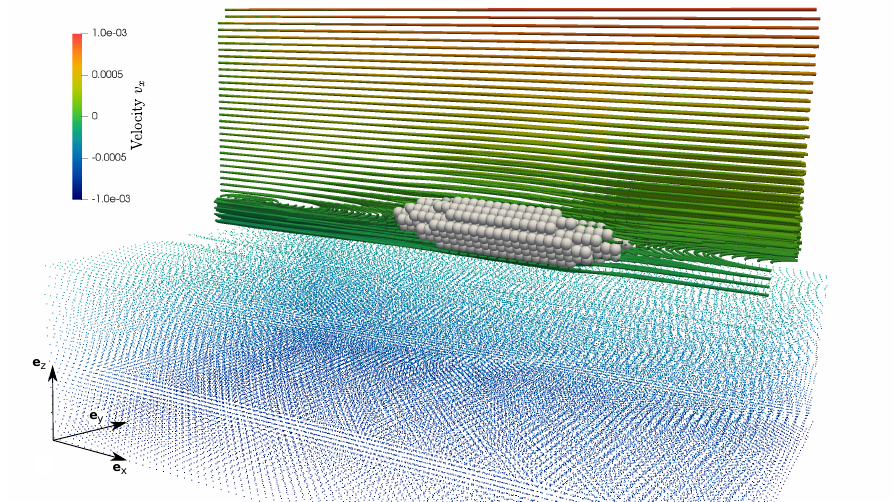
Figure 9. 3-dimensional view of the simulation results showing streamlines of the velocity v x in the channel. Prolate spheroid is aligned with e x -axis and does not perform any rotation for a Reynolds number of Re =